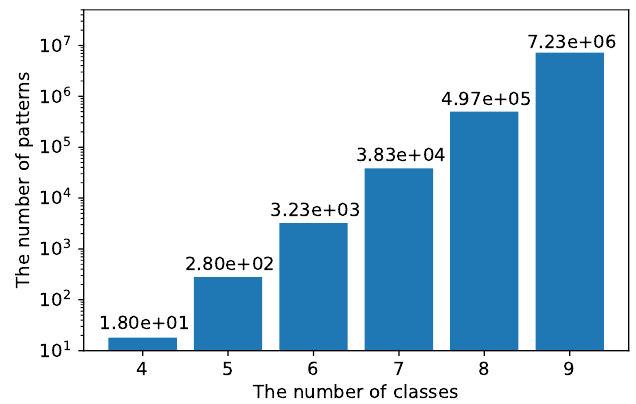
Figure 8. The number of combinations of class hierarchies of height 3 per original number of